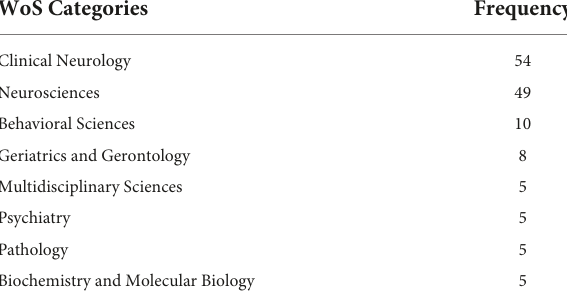
TABLE 4 The number of study fields on the basis of WOS categories.